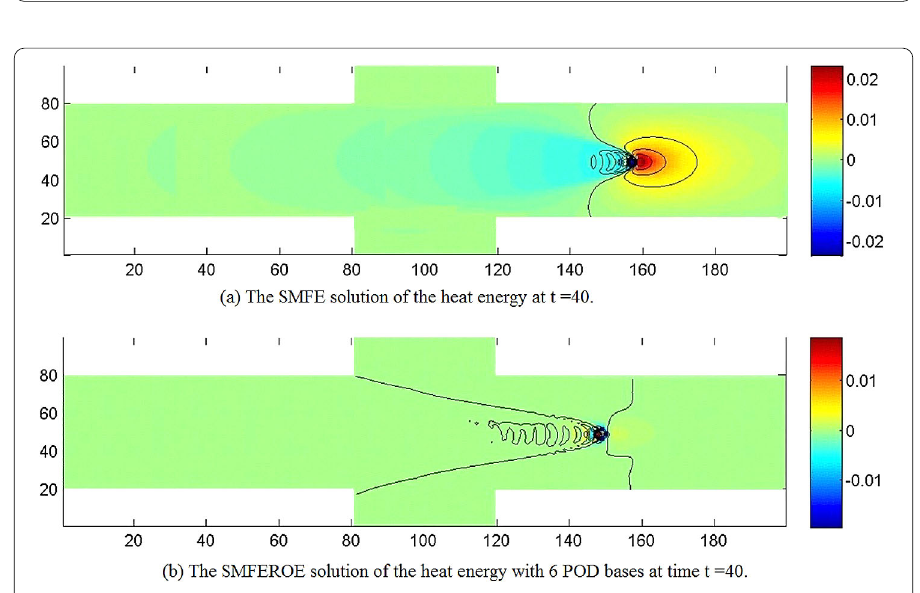
Figure 4 The numerical solutions of the heat energy. (a) The SMFE solution of the heat energy Q at t = 40 when Re = 1,000 and Pr = 7. (b) The SMFEROE solution of the heat energy Q with 6 POD bases at time t = 40 when Re = 1,000 and Pr =